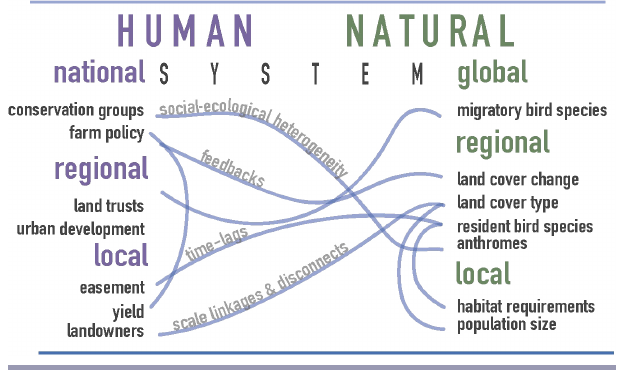
Fig. 1 . Conceptual model of key human (blue) and natural (green) systems and subsystems and the interactions within and between systems.